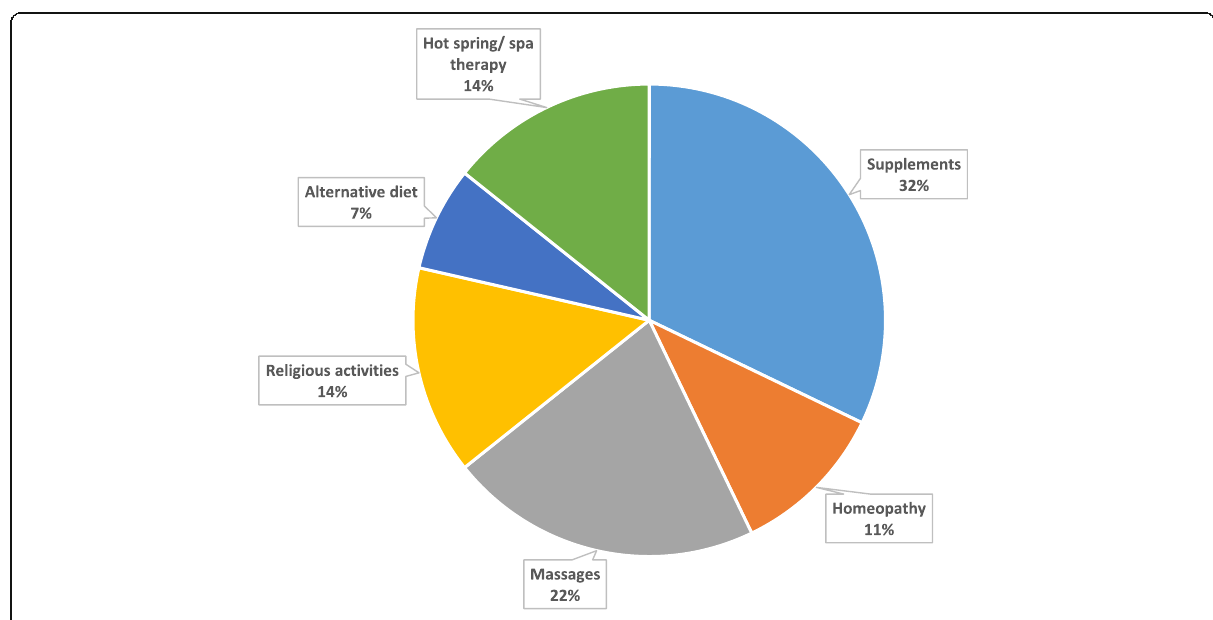
Fig. 1 Complementary Health Approaches (CHA) Among Children with